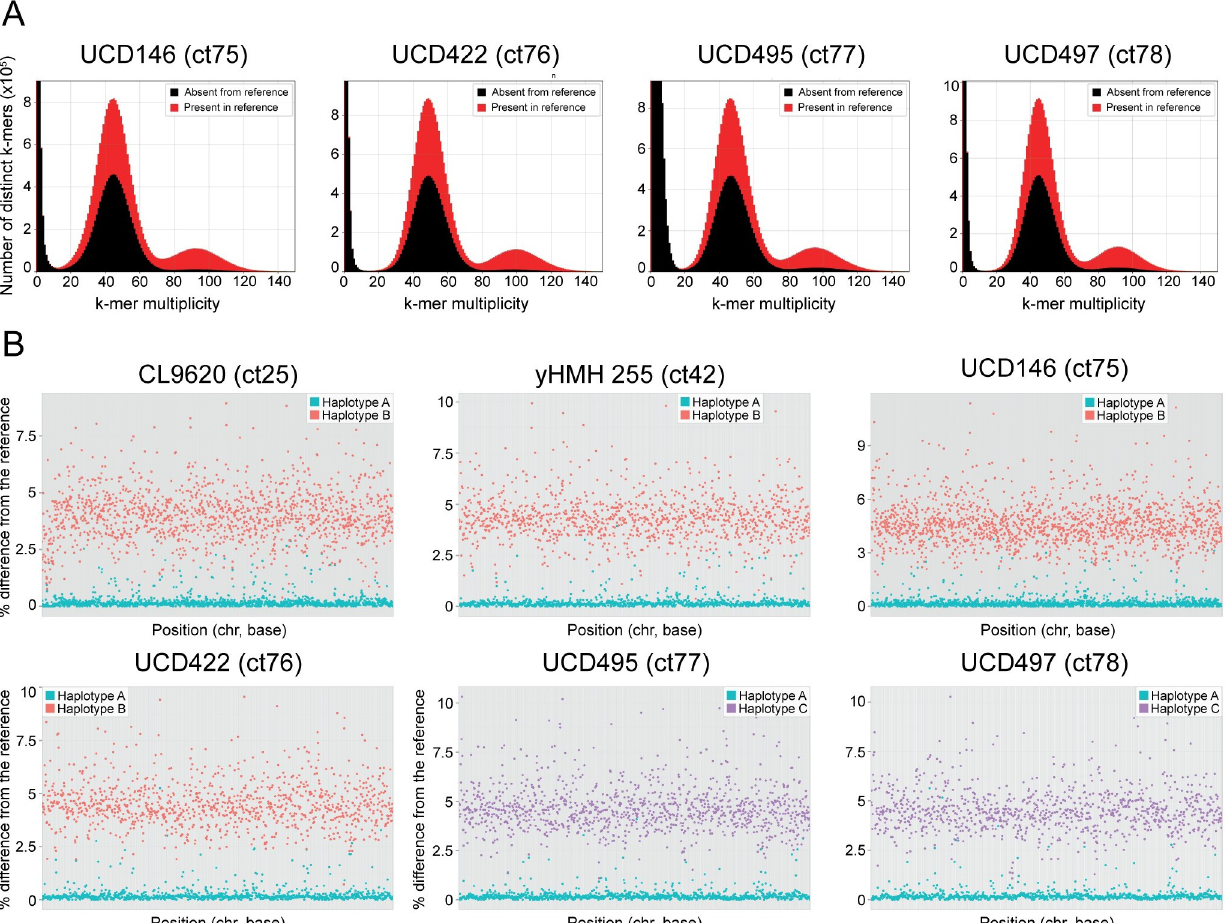
Fig 2. Novel C . tropicalis isolates result from hybridization. (A) Analysis of k -mer distribution profiles reveals hybrid genomes. K -mer analysis of sequencing readsets was performed with the k -mer Analysis Toolkit (KAT [82]). For each of four divergent isolates, the number of distinct k -mers of length 27 bases (27-mers) is displayed on the Y-axis and k -mer multiplicity (depth of coverage) is displayed on the X-axis. K -mers that are present in the reference genome are shown in red, and k -mers that are absent from the reference genome are shown in black. There are two distinct peaks of k -mer coverage at approximately 50X and 100X. This pattern implies that most of the genomes are heterozygous ( k -mers at 50X coverage) with few homozygous regions ( k - mers at 100X coverage). Approximately half of the heterozygous k -mers in the readsets are not represented in the reference sequence. This pattern has been observed in hybrid isolates from other yeast species [25]. (B) Analysis of phased variants identifies two distinct haplotypes in divergent isolates of C . tropicalis . Variants were phased using HapCUT2 [44] into blocks covering 10–13 Mb of the genome. For each phased block, percentage difference from the reference strain in each haplotype was calculated as the number of variants divided by the length of the block. For 84–87% of the blocks, one haplotype is < 0.3% different to the reference sequence and one haplotype is > 1% different to the reference sequence. All phased blocks for each of the six hybrid isolates are shown as haplotype pairs, with the member of the pair more similar to the reference (haplotype A) shown in blue and the member of the pair less similar to the reference shown in orange (haplotype B) or purple (haplotype C). Percentage difference to the reference sequence is displayed on the Y- axis and position in the genome (chromosome, position (bp)) is displayed on the X-axis.